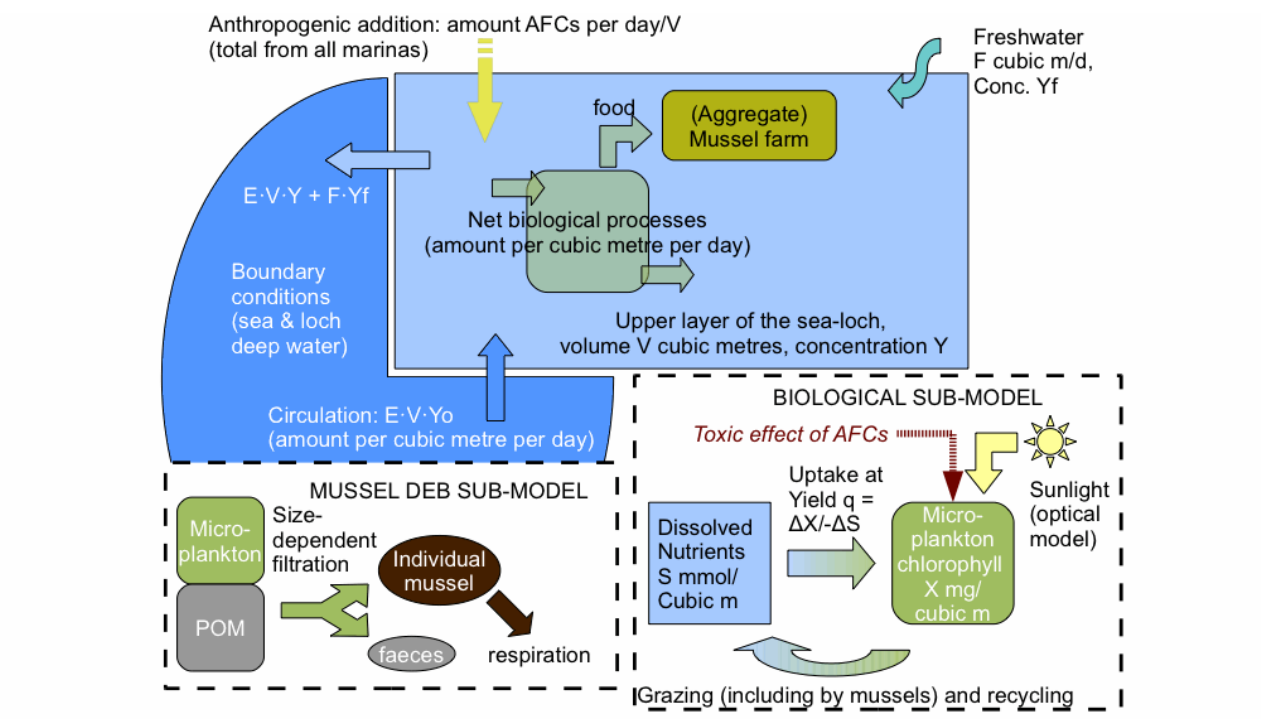
Fig. 4 . The physical-biological components of the system